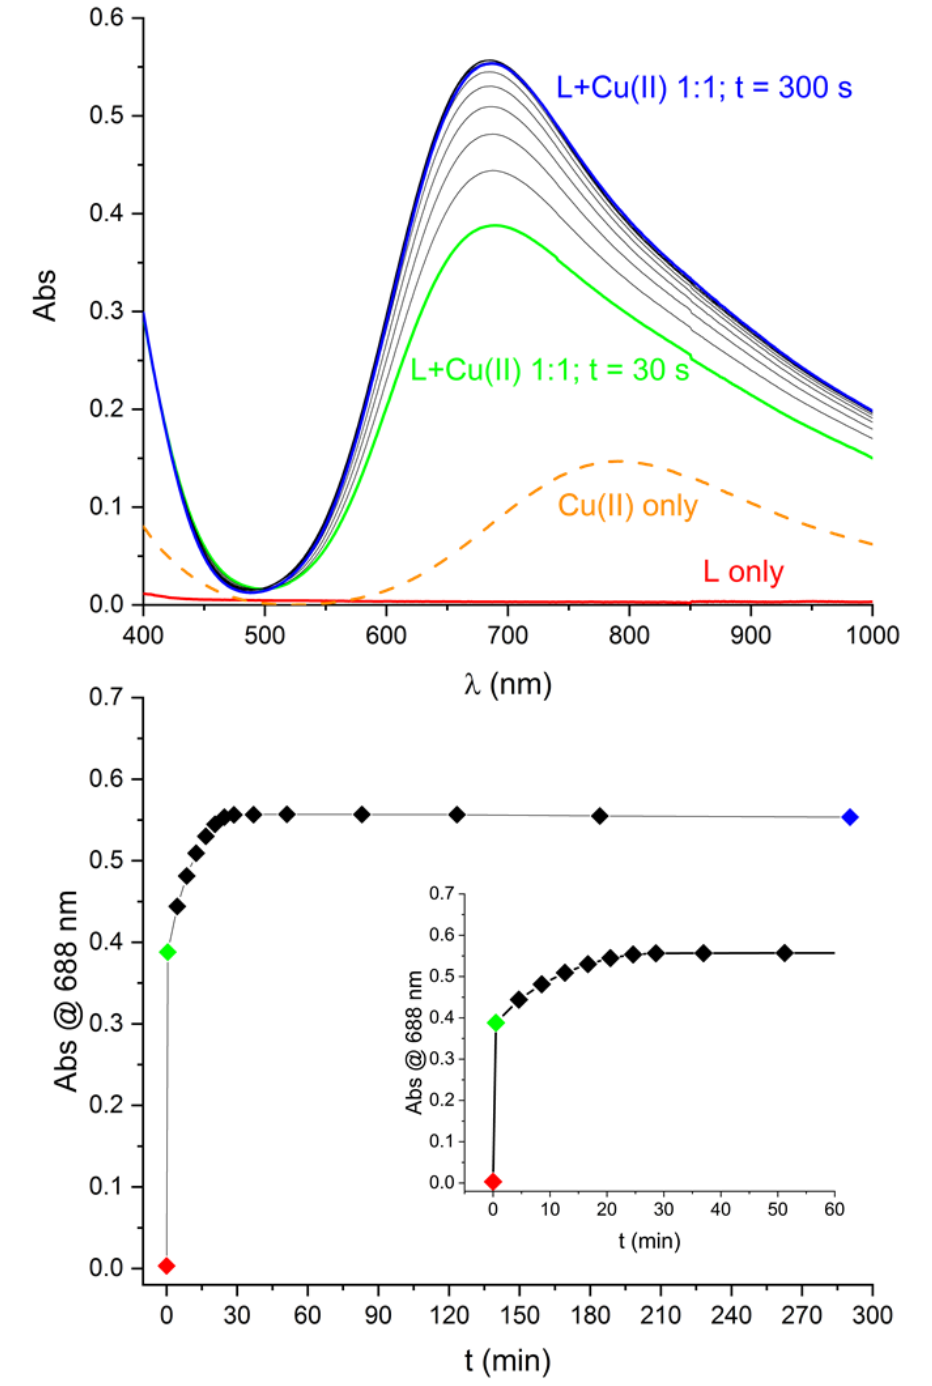
Figure 2. Top: temporal evolution of the absorption spectra of a DMF solution of L ([L] = 1.8 mM) after addition of 1 eq of Cu(II). Cu(II) only 1.8 mM in DMF. Bottom: evolution of the 688 nm spectral maximum over time showing that invariant spectrum is achieved within 1